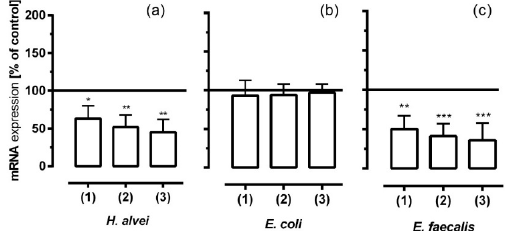
Figure 7. The effect of ACNs fermented by H. alvei ( a ); E. coli ( b ) and E. faecalis ( c ) on NF ‐ κ B mRNA